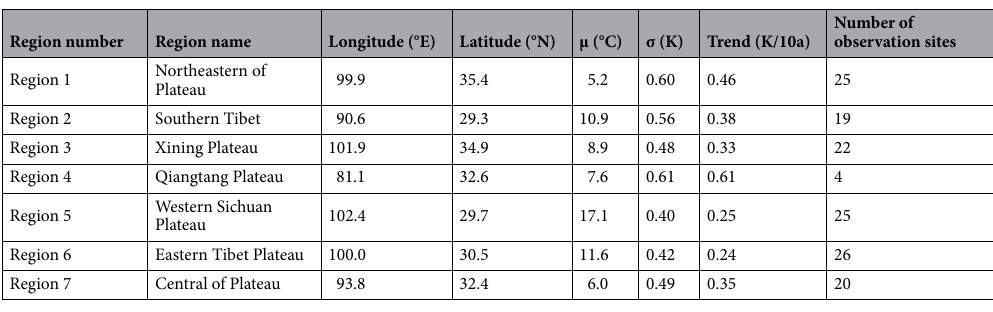
Table 2. Environmental parameters of the region